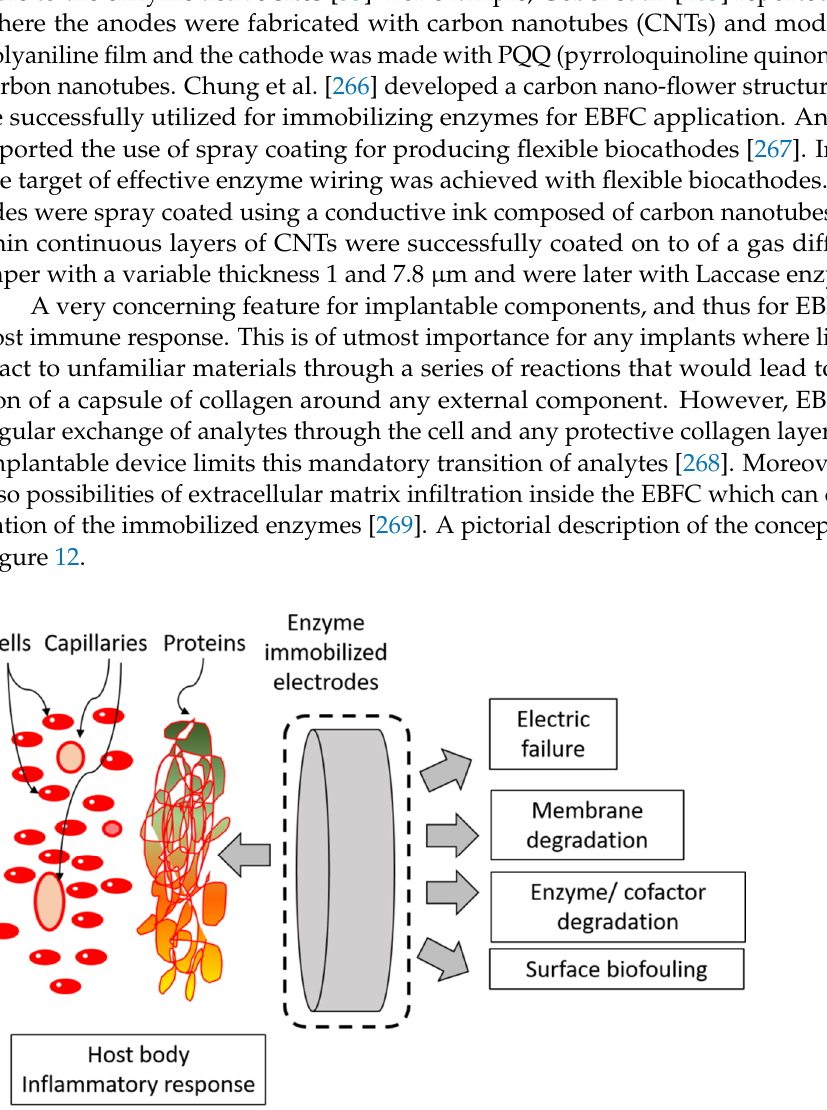
Figure 13. Classifying EBFCs according to their placement. Studies on in vitro EBFCs, i.e., EBFCS which have been tested outside any living organism and in a lab environment, have been widely reported. One such experiment was presented by Castorena-Gonzalez et al. [274] where bucky paper electrodes were used. The anode was modified with PQQ-dependent glucose dehydrogenase, which is a quinoprotein enzyme with PQQ cofactor for facilitating glucose oxidation [275], and the cathode used laccase. The cell was initially tested in human serum solution and then on exposed rat cremaster tissue. Szczupak et al. [276] informed about an EBFC with a bien- zymatic trehalose glucose oxidase trehalose anode and a bilirubin oxidase dioxygen